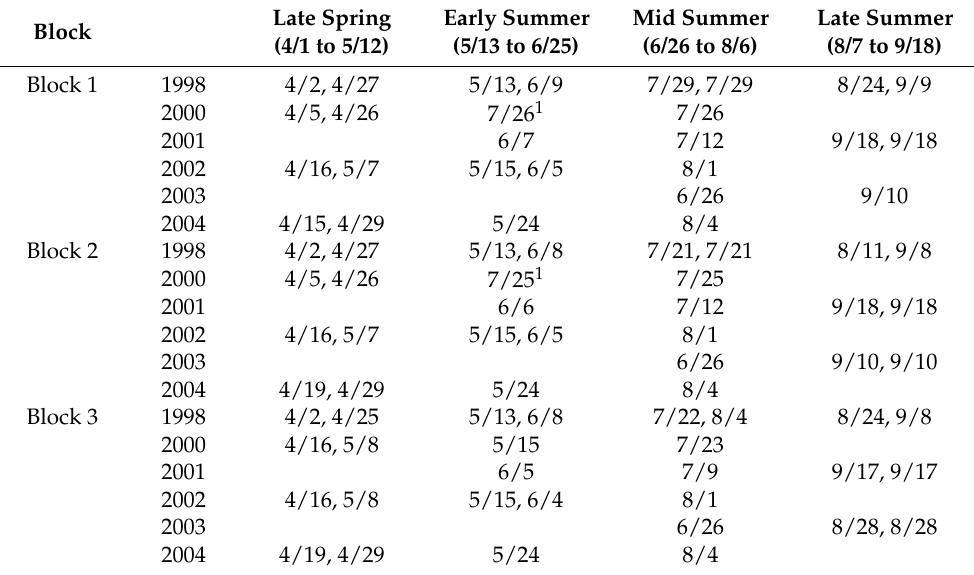
Table 1. Burn windows and dates of growing season prescribed fires in the Piedmont National Wildlife Refuge near Macon, Georgia, USA. Dates are represented as